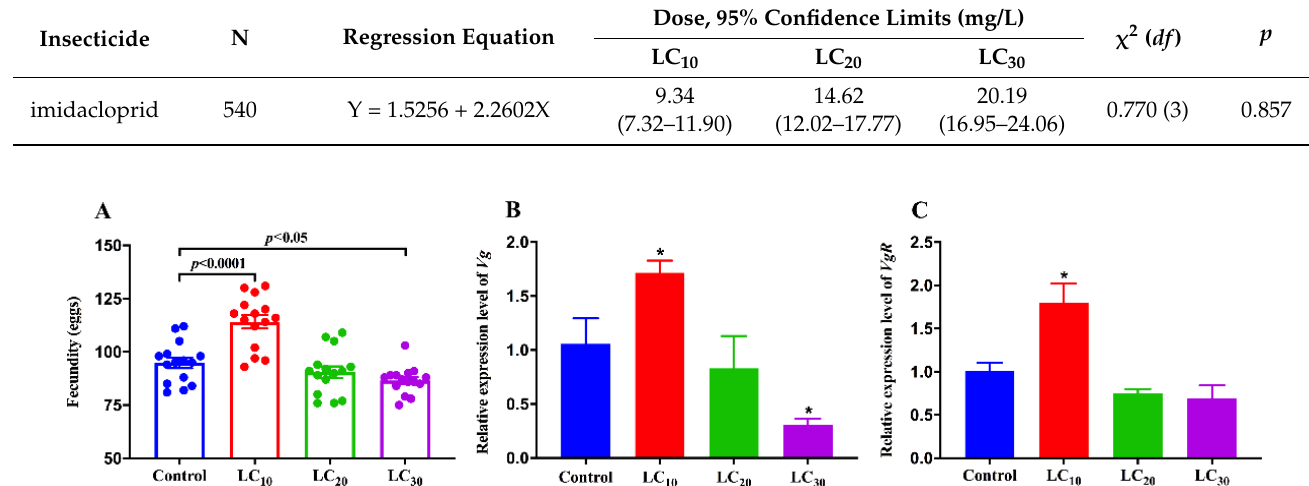
Figure 1. Sublethal effects of imidacloprid on the fecundity of the viruliferous SBPH. ( A ) The number of eggs laid in the viruliferous SBPH exposed to sublethal concentrations of imidacloprid. The transcript levels of Vg ( B ) and VgR ( C ). Data were analyzed by Student’s t -test. The asterisk in ( B , C ) indicates significant differences between the treatment and the control (* p < 0.05).